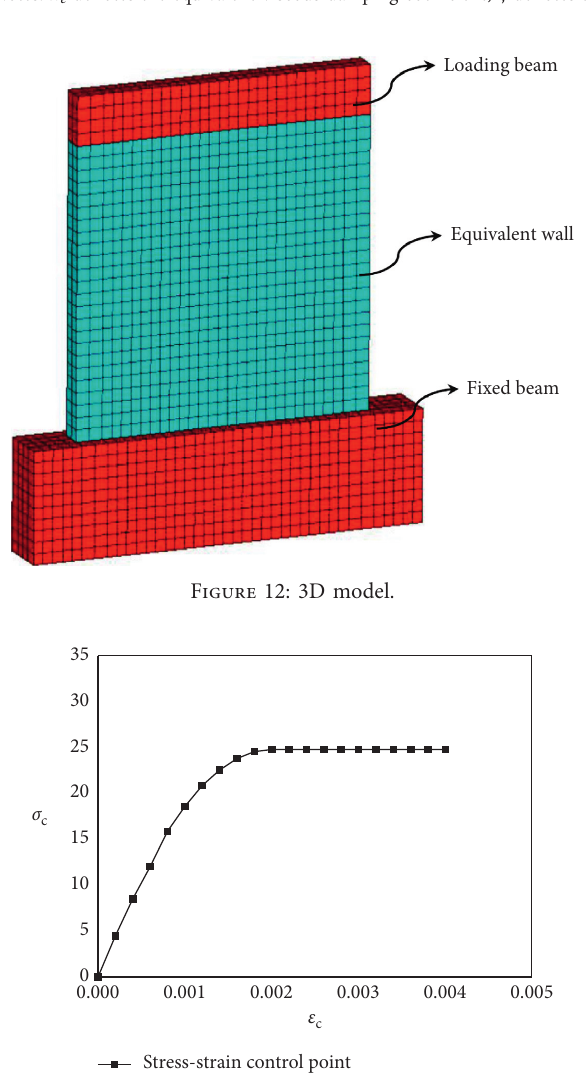
Figure 13: Stress-strain relationship. plump. The framework curve in Figure 15 indicates that the calculation results are greater than test results. The cause of this phenomenon is discussed as follows. During simulation, the slippage between the insulation plate and wall is ignored. The wall material is ideal, without considering errors generated during actual production (insufficient vibration of plaster and concrete), or defects produced during transportation and in- stallation (such as damage of wall corner and wall side).